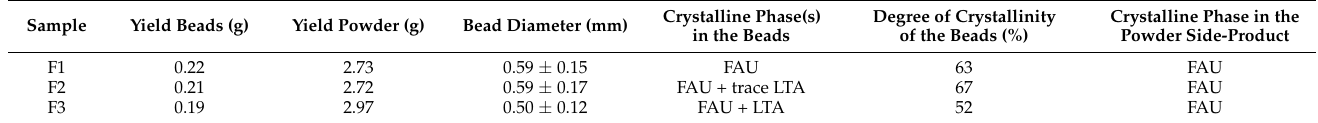
Figure 1. Synthesis of binderless zeolitic beads using an anion-exchange resin as a hard template. The three binderless Faujasite beads were synthesized by adapting a literature method for zeolite Y powder [24] and by varying the ageing and crystallization times in order to optimize the crystallinity and purity of the obtained beads. The average bead size was measured using an optical microscope and was 0.59 mm for the F1-beads and F2-beads and 0.50 mm for the F3-beads (Table 1). Table 1. Yield and crystalline phase of the zeolitic beads and of the powder side-products.